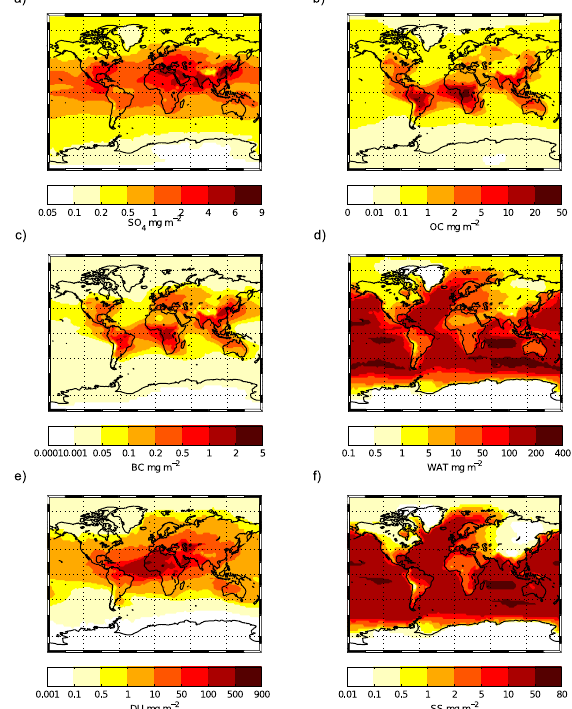
Fig. 2. Annual mean of vertically integrated column mass for year 2008 for (a) sulphate (SO 4 ), (b) organic carbon (OC), (c) black car- bon (BC), (d) particulate water (WAT), (e) dust (DU) and (f) sea salt (SS) simulated with SALSA. All units aremg m − 2